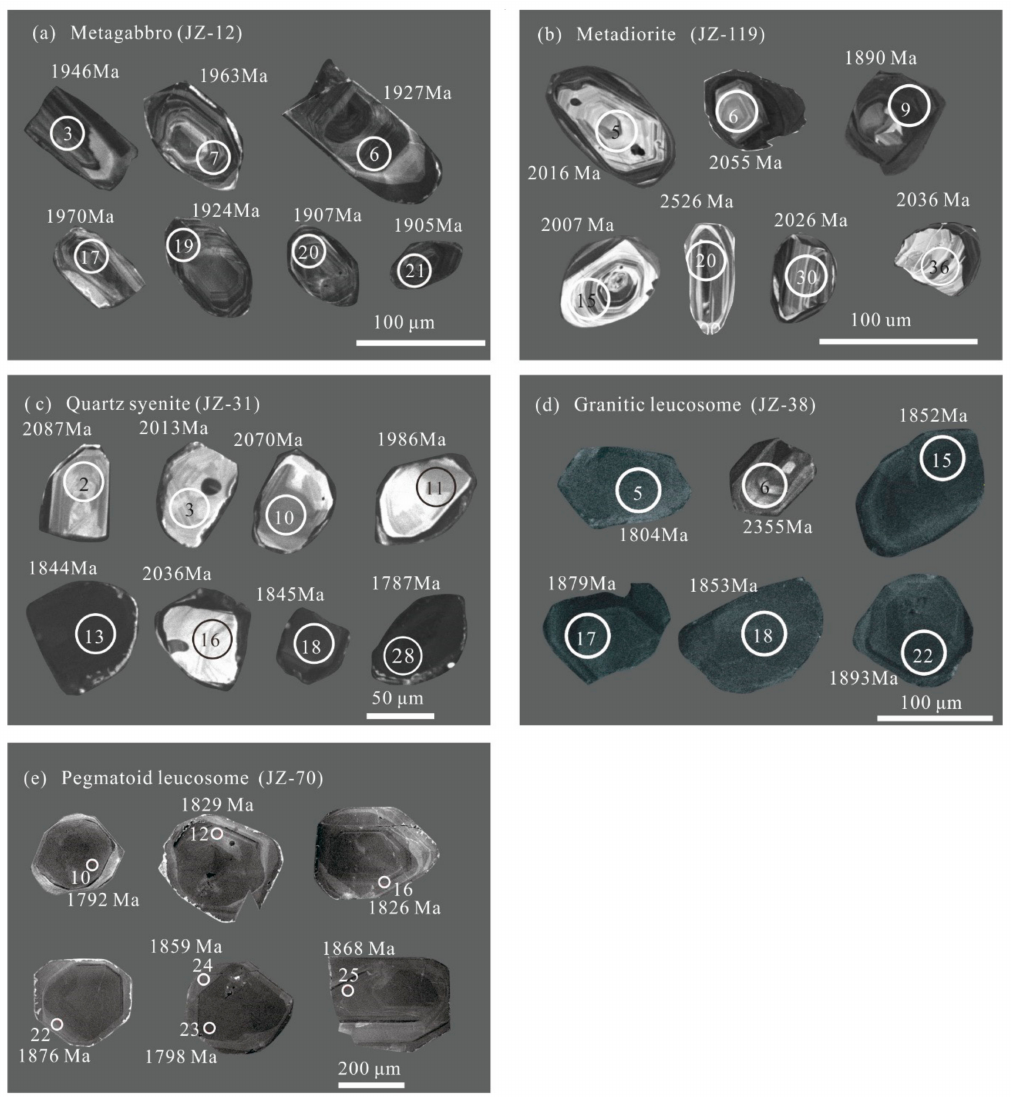
Figure 7. CL images of zircons. ( a ) Metagabbro sample JZ-12; ( b ) metadiorite sample JC-119; ( c ) quartz syenite sample JZ-31; ( d ) granitic leucosome sample JZ-38; ( e ) pegmatoid leucosome sample JZ-70. Circles denote U–Pb analysis spot. Numbers in the circles are the spot numbers. Numbers near the analytical spots are the U–Pb ages